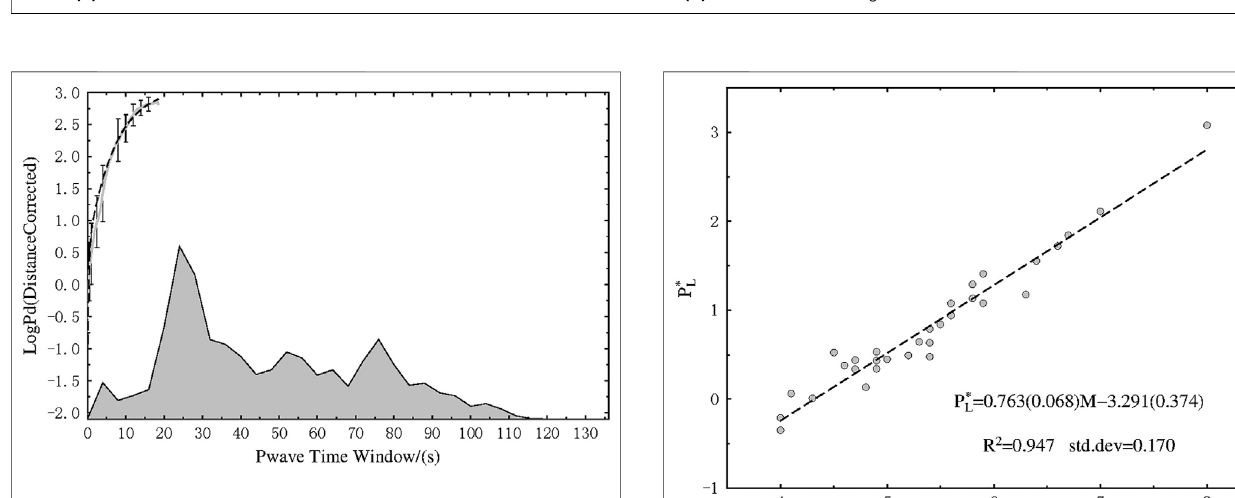
FIGURE 4 | The LPDT curve of the M 8.0 Wenchuan earthquake and its fi t model. The grey and the dashed line represent the observed data and the best fi tmodel,respectively.ThestandarderrorofthecorrectedamplitudePd C for the available stations at each P-wave time window is shown by the vertical error bars. The moment rate function of this event provided by the USGS was shown in the bottom with grey area.